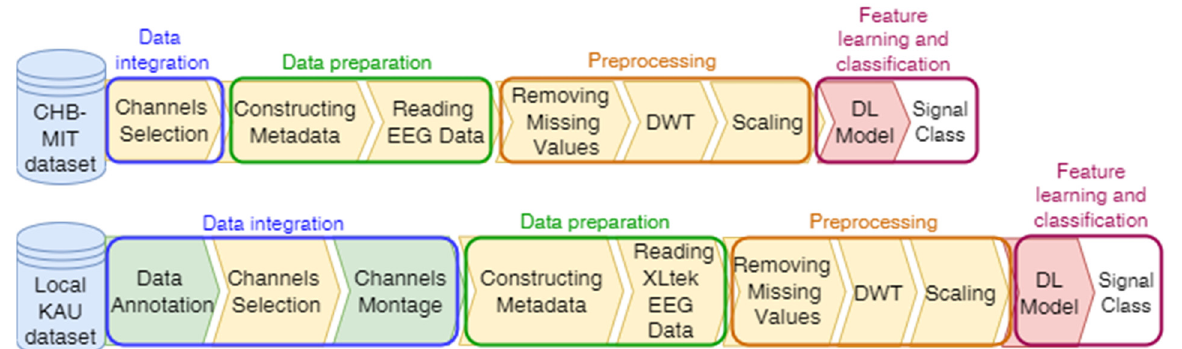
Figure 1. The proposed compatibility framework architecture.